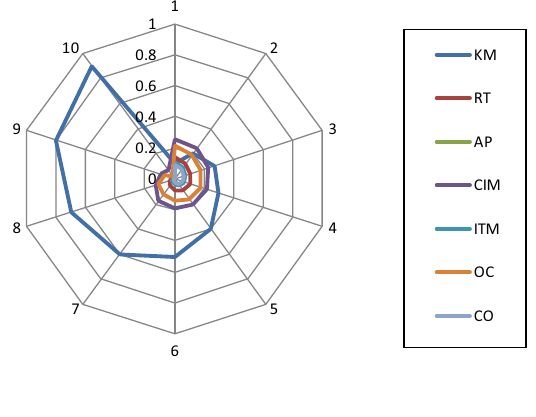
Figure 2. Results of sensitivity